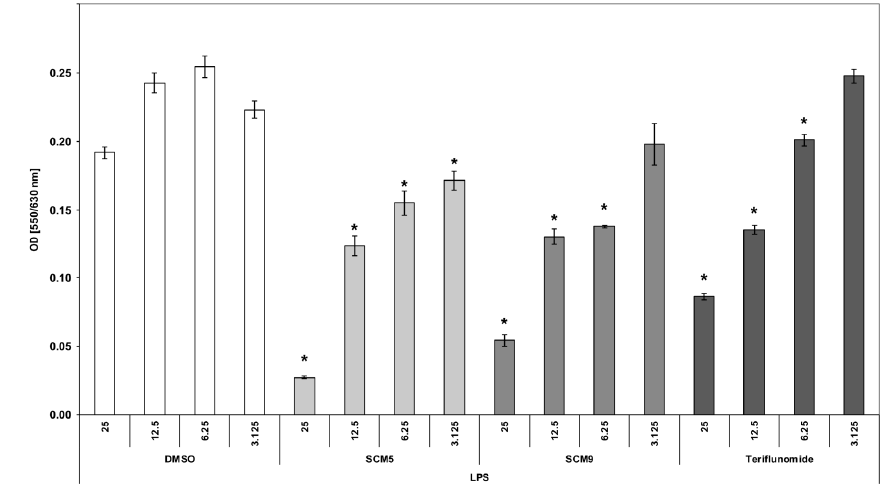
Figure 4. The effect of SCM compounds on LPS-induced mouse splenocyte proliferation. The compounds were added to the cultures at concentrations of 25, 12.5, 6.25 and 3.125 µM, and LPS (50 µg/mL) as inducer of cell proliferation. After 3-day incubation, the cell proliferation was determined using a colorimetric MTT assay. Teriflunomide served as a reference drug. The results are presented as the OD values from quadruplicate determinations (mean ±SE). * indicates statistical significance when p < 0.05, versus DMSO